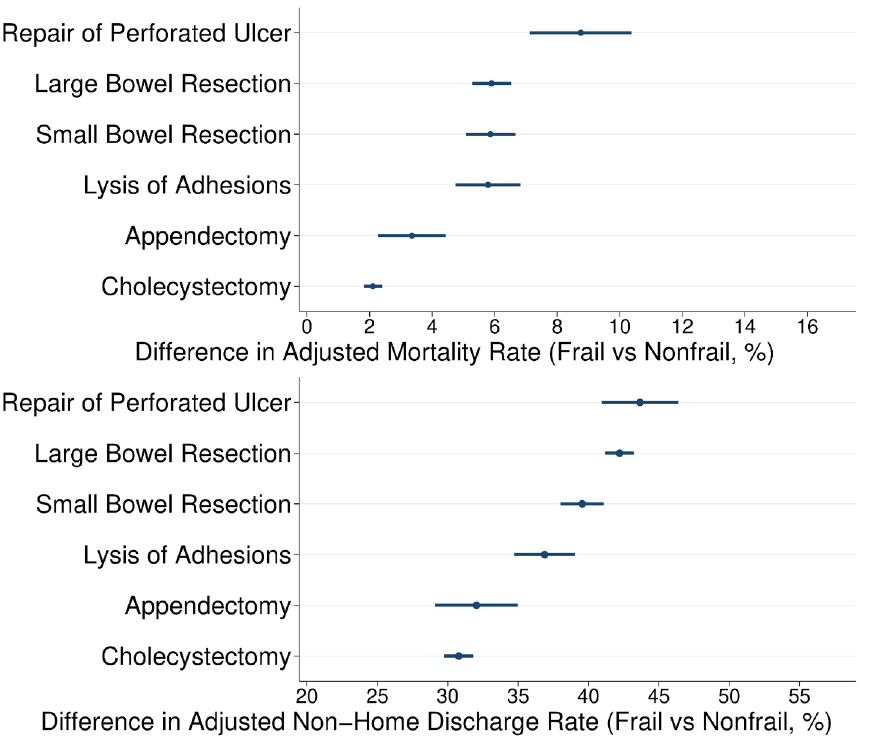
Fig 1. Differences in adjusted rates of mortality (top) and non-home discharge (bottom) in Frail versus Nonfrail patients. Estimate represents mean absolute difference in adjusted mortality or non-home discharge rate, with 95% confidence interval, by operation